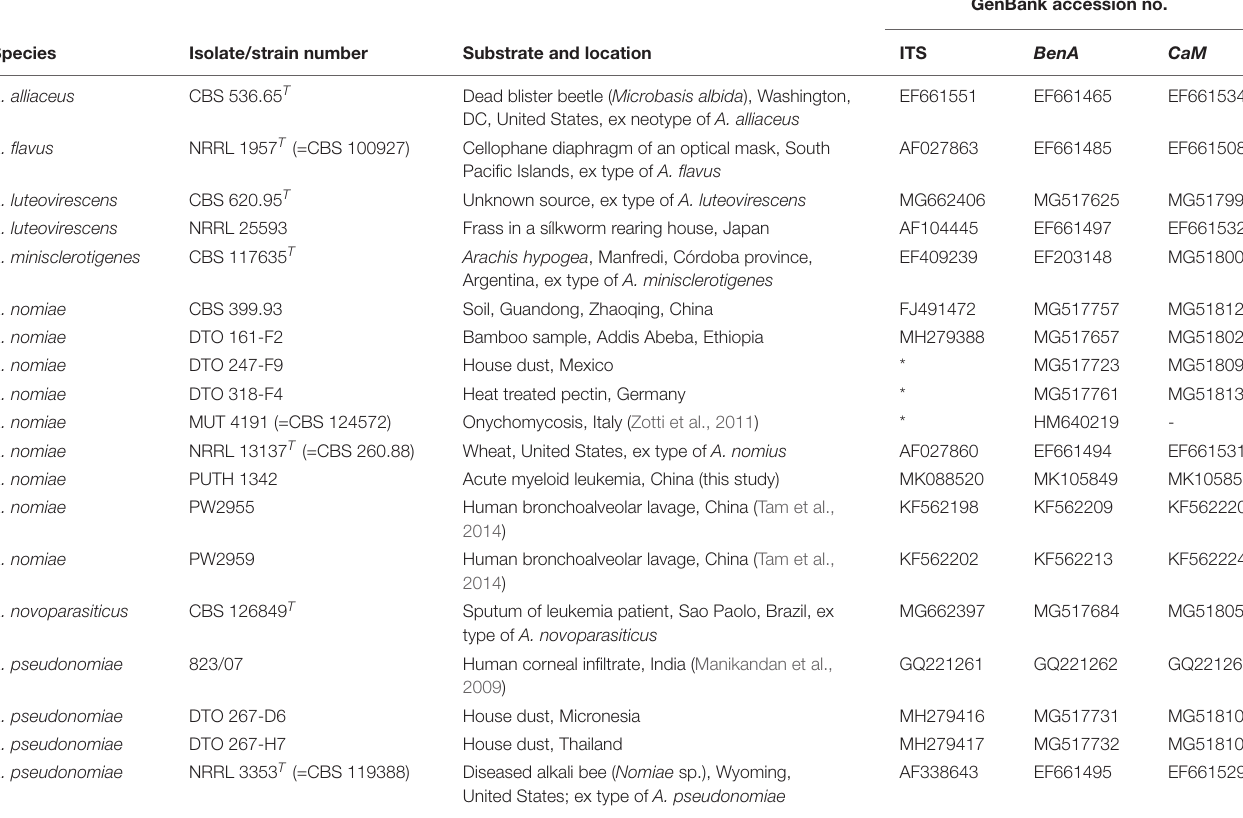
TABLE 1 | List of strains used in this